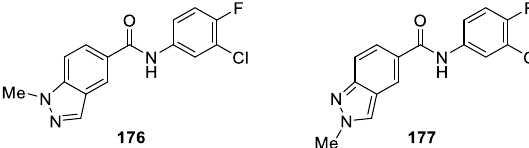
Figure 57. Chemical structures of N -alkylated indazole-5-carboxamide derivatives 176 and 177 .